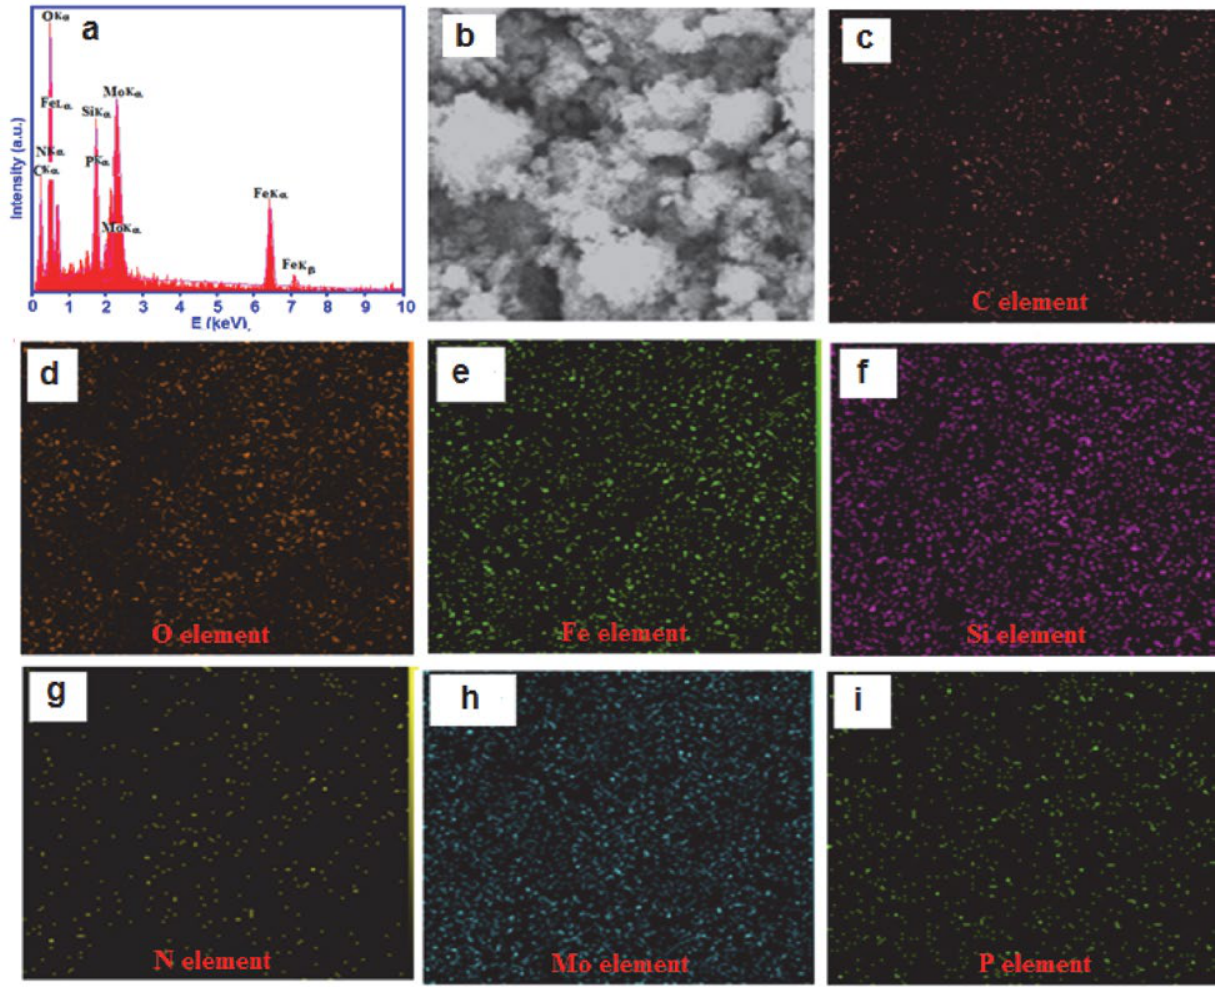
Figure 7. (a) EDX spectrum, and (b)-(i) a representative SEM image of the Fe EDX elemental mappings.